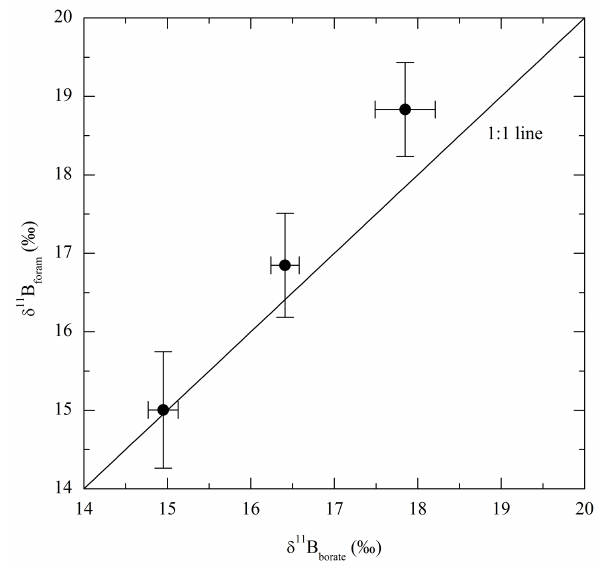
Figure 4. δ 11 B of borate vs. that of calcite. δ 11 B borate was calcu- lated using the fractionation factor of 11 − 10 K B = 1 . 0272 (Klochko et al., 2006) at T = 23 ◦ C and S = 38. Error bars for δ 11 B foram rep- resent ± 2 σ errors, and for δ 11 B borate the translated uncertainty of pH measurements (Table